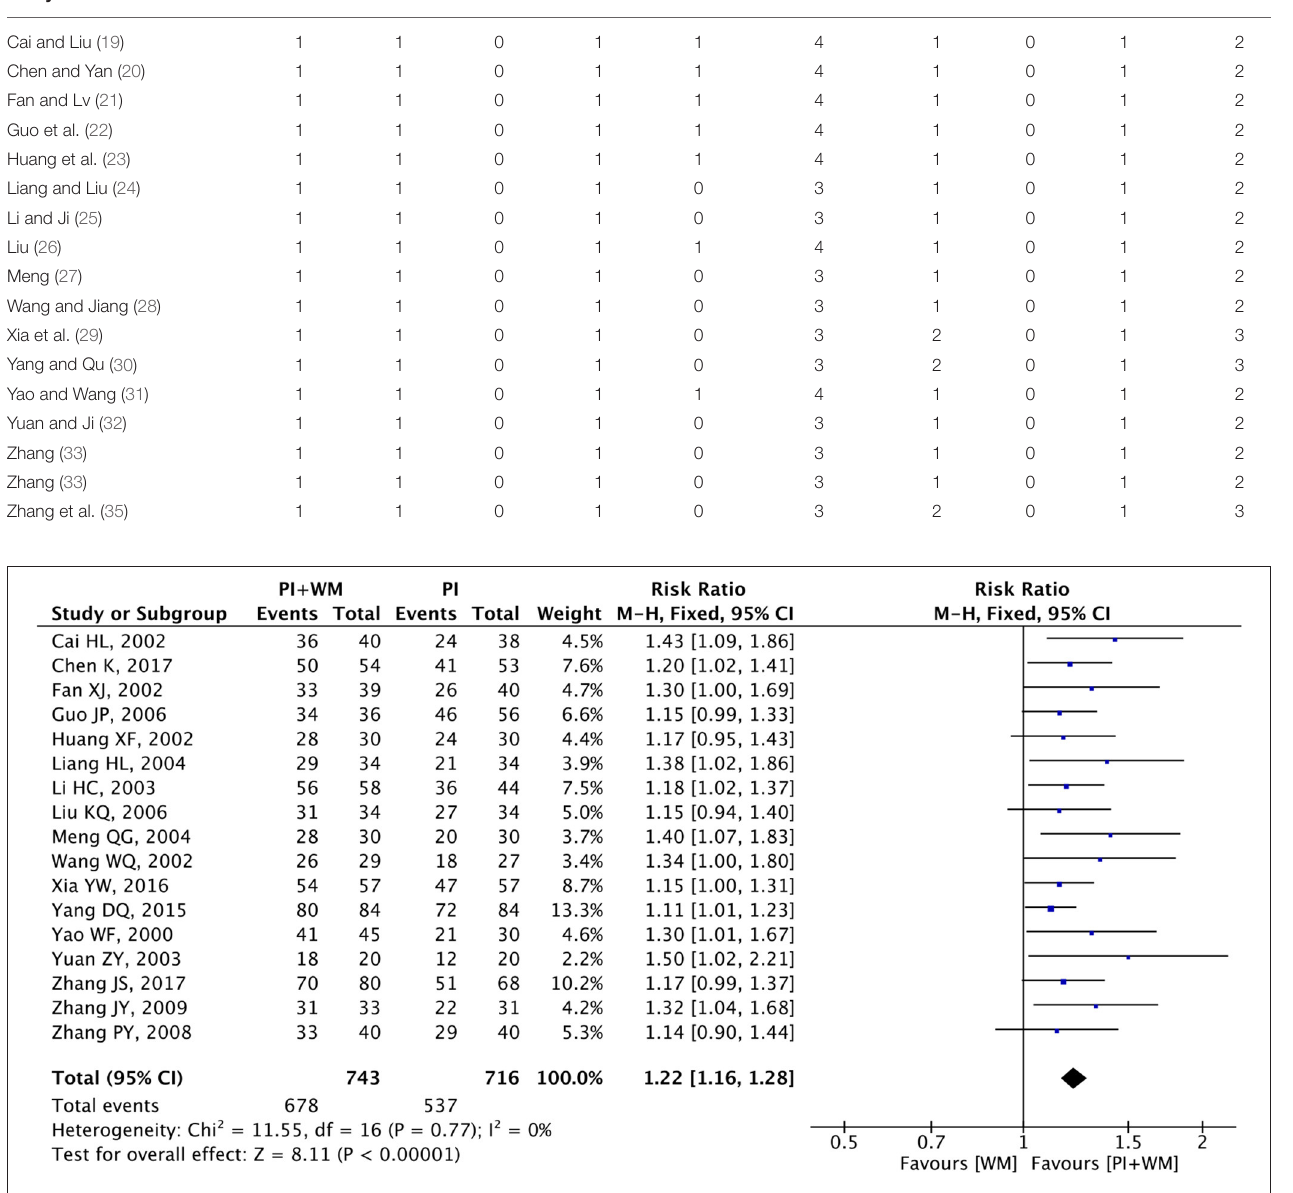
FIGURE 2 | Forest plot of outcome measure symptoms. PI is puerarin injection and WM is Western